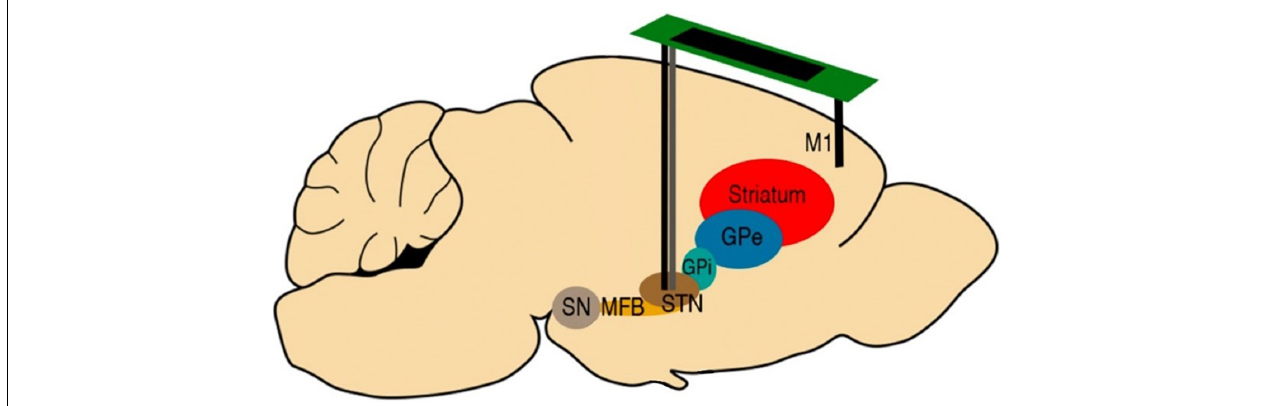
FIGURE 2 | Schematic description of the electrode implantation sites. All rats received bilateral implantations of Platinum-Iridium bipolar recording electrodes (10 mm diameter, black) to both the STN and M1. Rats in the PD group were also implanted with bipolar stimulation electrodes (50 mm diameter, gray) in the STN ipsilateral to the lesion, adjacent to the recording electrodes. Figure adapted from Mottaghi (2020).